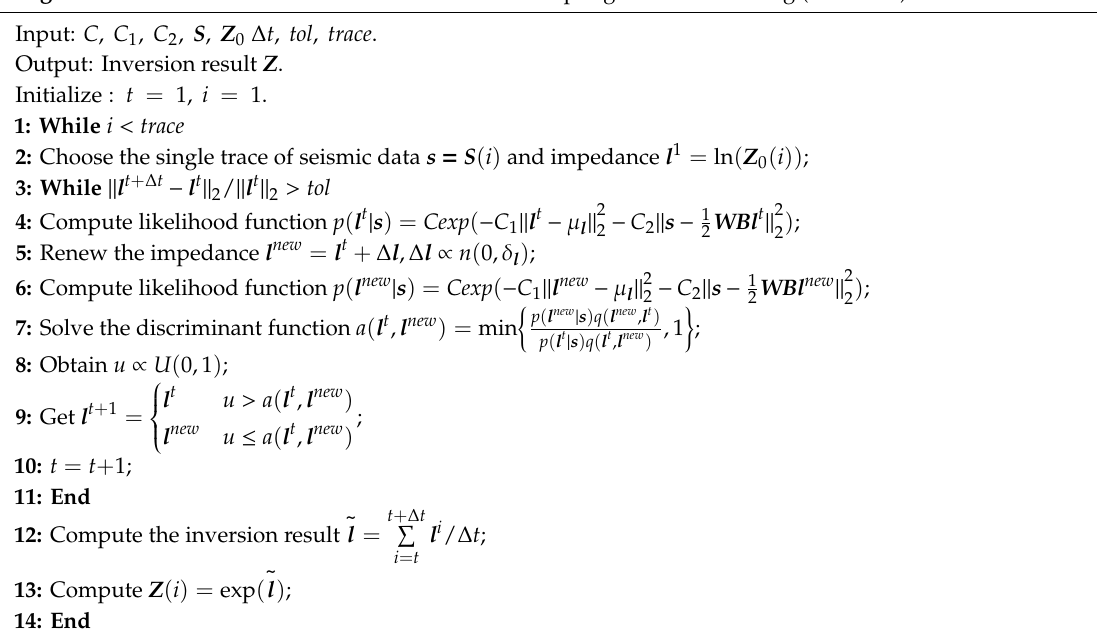
Algorithm 2 The inversion based on Gaussian MH sampling with data driving